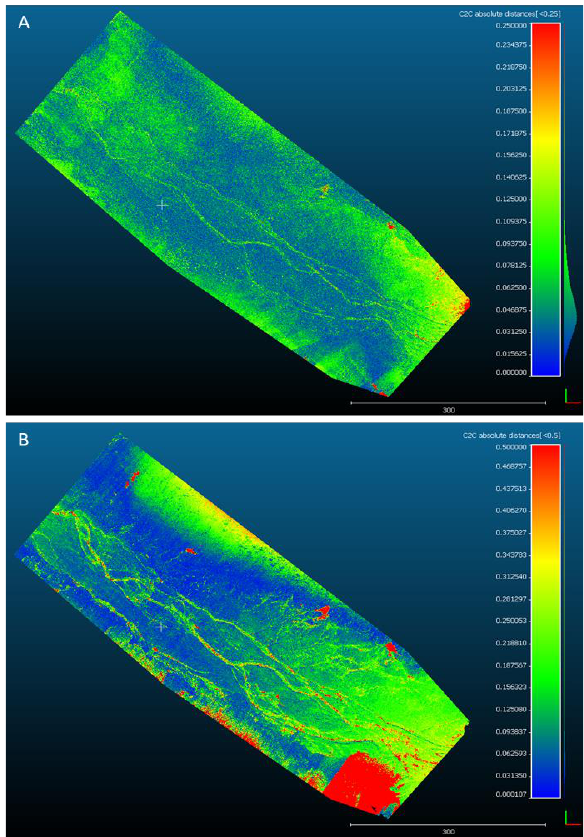
Figure 10. Point cloud differences between Agisoft and Pix4D model (A); Pix4D and LiDAR (B)